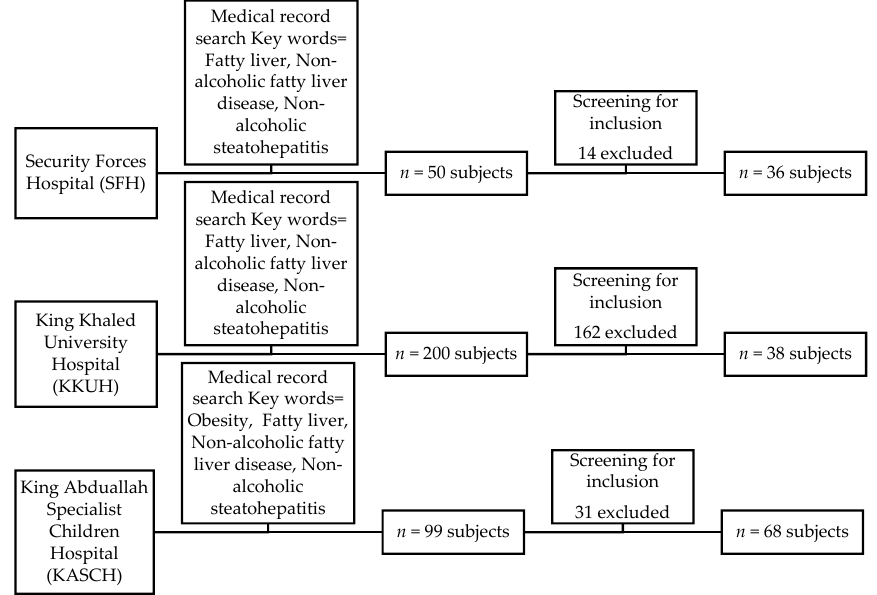
Figure 1. Flow chart of the study subjects’ recruitment process.